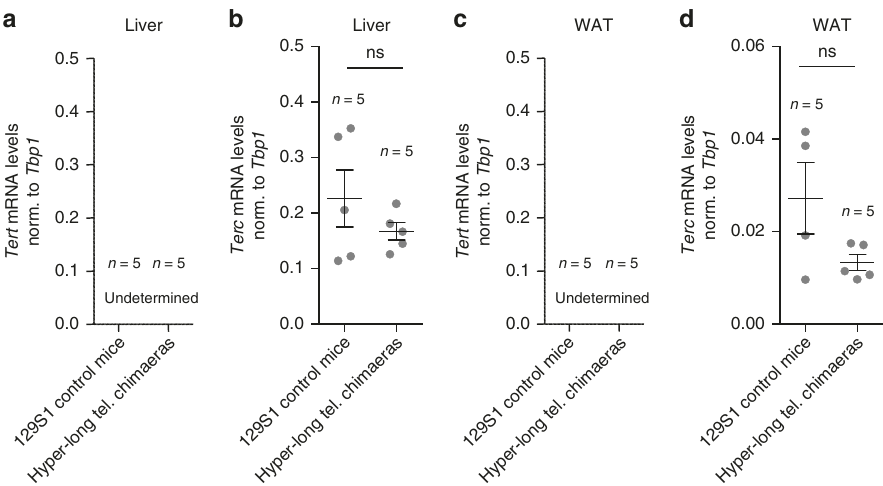
Fig. 7 Hyper-long telomere mice does not present altered telomerase expression levels. a – d Tert and Terc mRNA expression levels as measured by Q-PCR in liver ( a , b ) and in white adipose tissue ( c , d ) in age-matched (100 weeks old) hyper-long telomere mice and control mice. Error bars represent standard error. t -test was used for statistical analysis. The number of mice is indicated in each case. * p < 0.05. ** p < 0,01. *** p < 0,001. Source data are provided as a Source Data fi